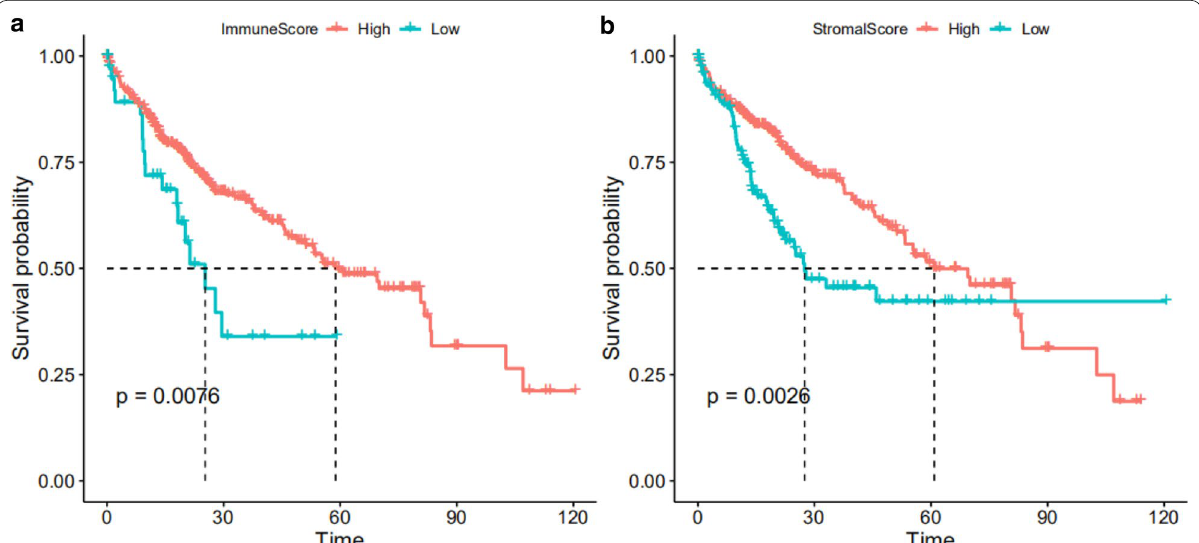
Fig. 2 Association of stromal and immune scores with HCC patient prognosis. a Kaplan–Meier survival curves for patients with low and high immune scores. b Kaplan–Meier survival curves for patients with low and high stromal scores